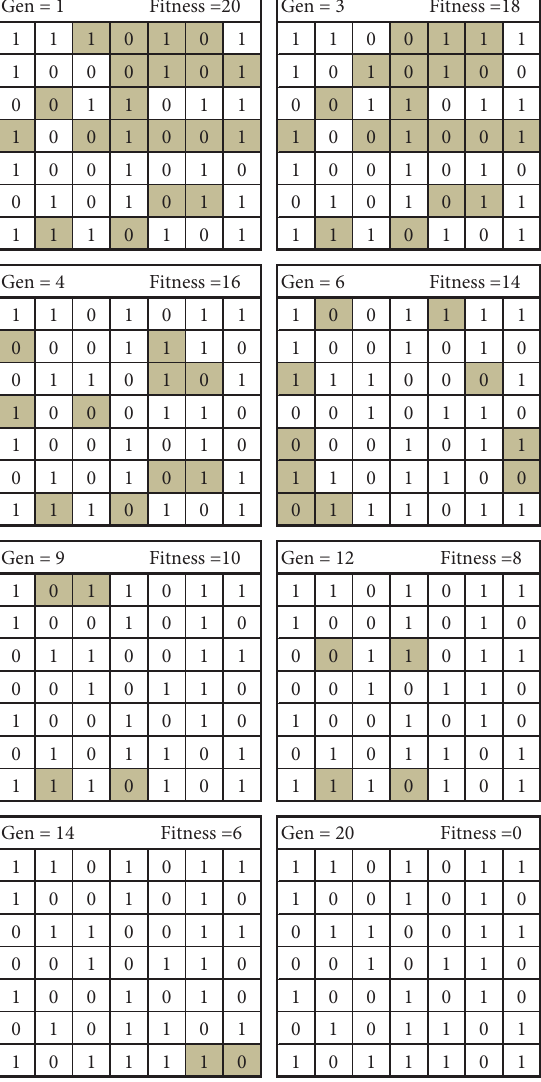
Figure 7: Solution’s progression of the base example (wrong values are highlighted).